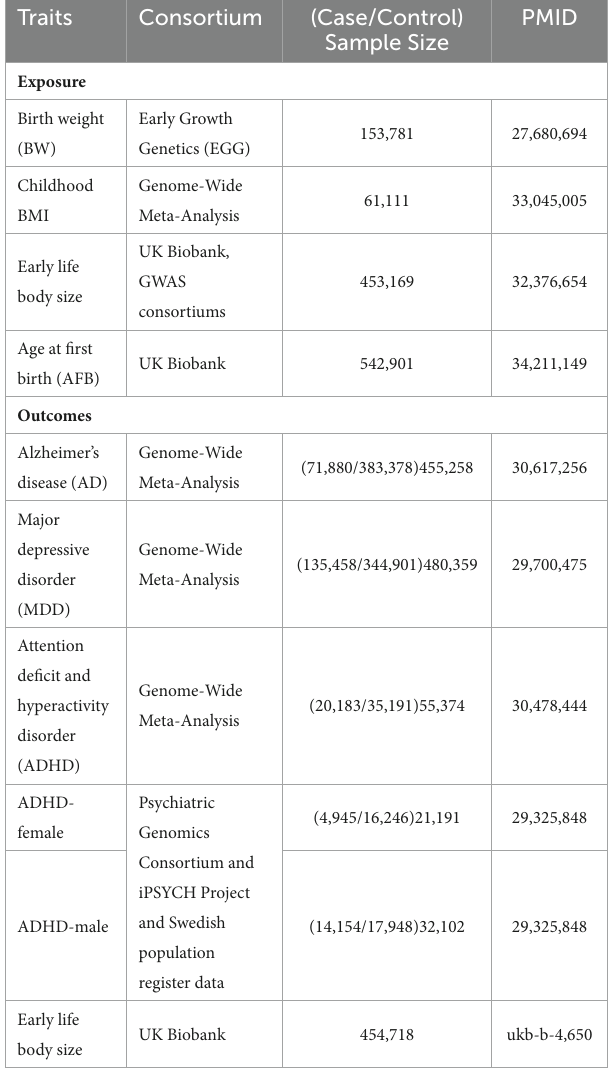
TABLE 1 Overview of exposure and seven outcomes GWAS. Traits